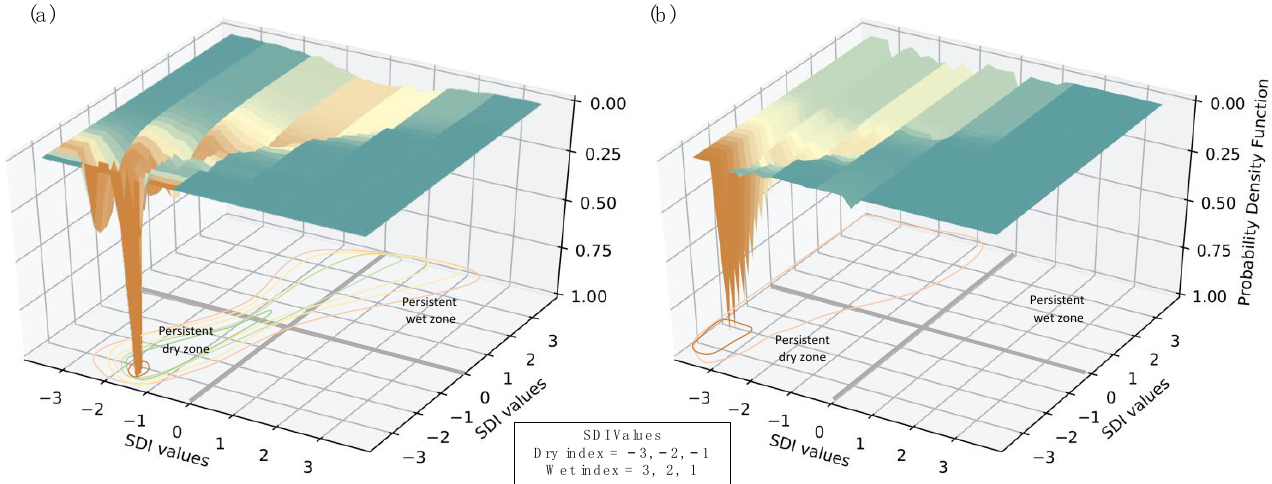
Figure 6. Stability landscapes of the Rio Grande-Rio Bravo at Above Amistad control point. ( a ) Natural flow regime (Figure 5A), two states are identified: (1) a persistent dry zone, characterized by a constricted-deep basin of attraction; and (2) a persistent wet zone, portrayed as one shallow-wide basin. ( b ) The regulated flow regime shows a single wide-deep basin of attraction pertaining to the persistent dry zone.